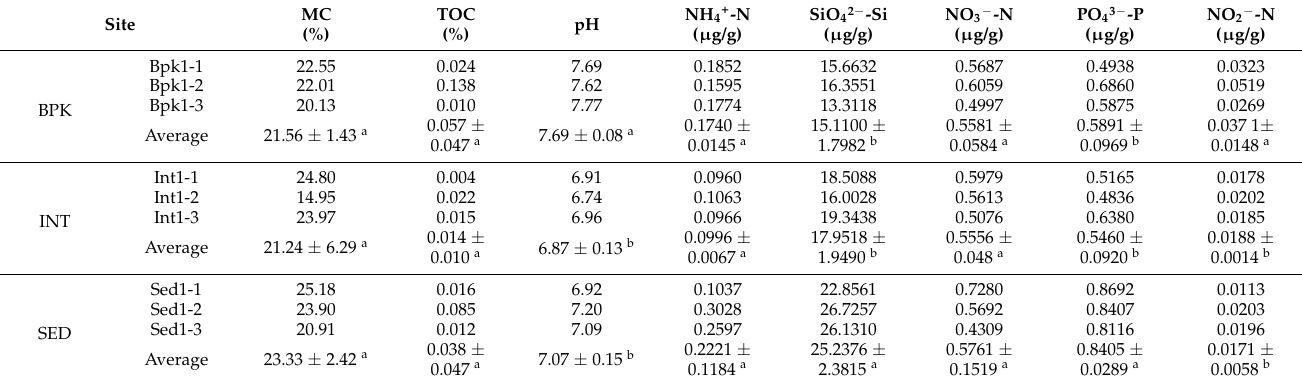
Table 1. Geochemical properties of sampling